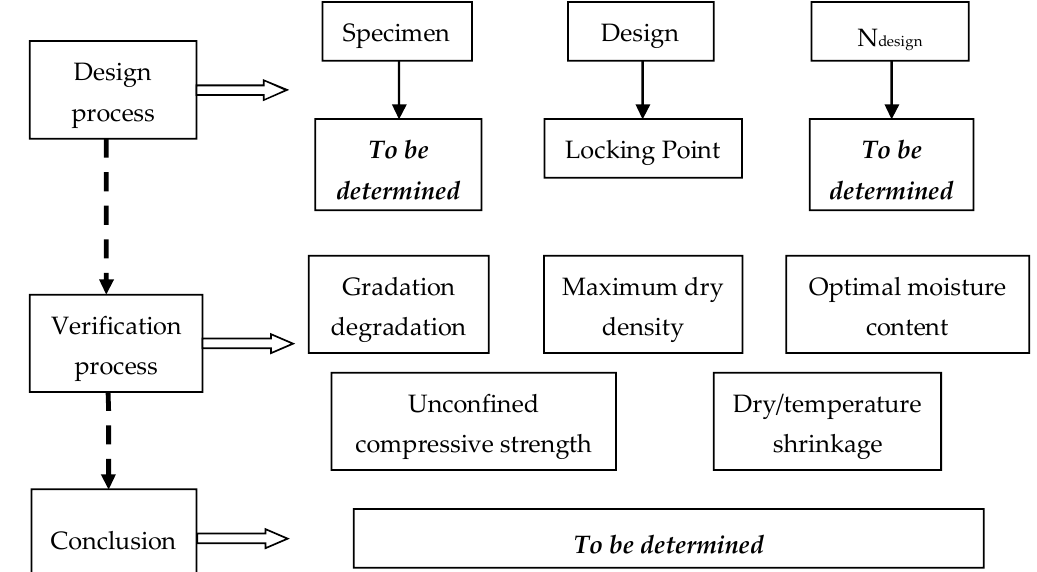
Figure 3. Schematic diagram of the research procedure.